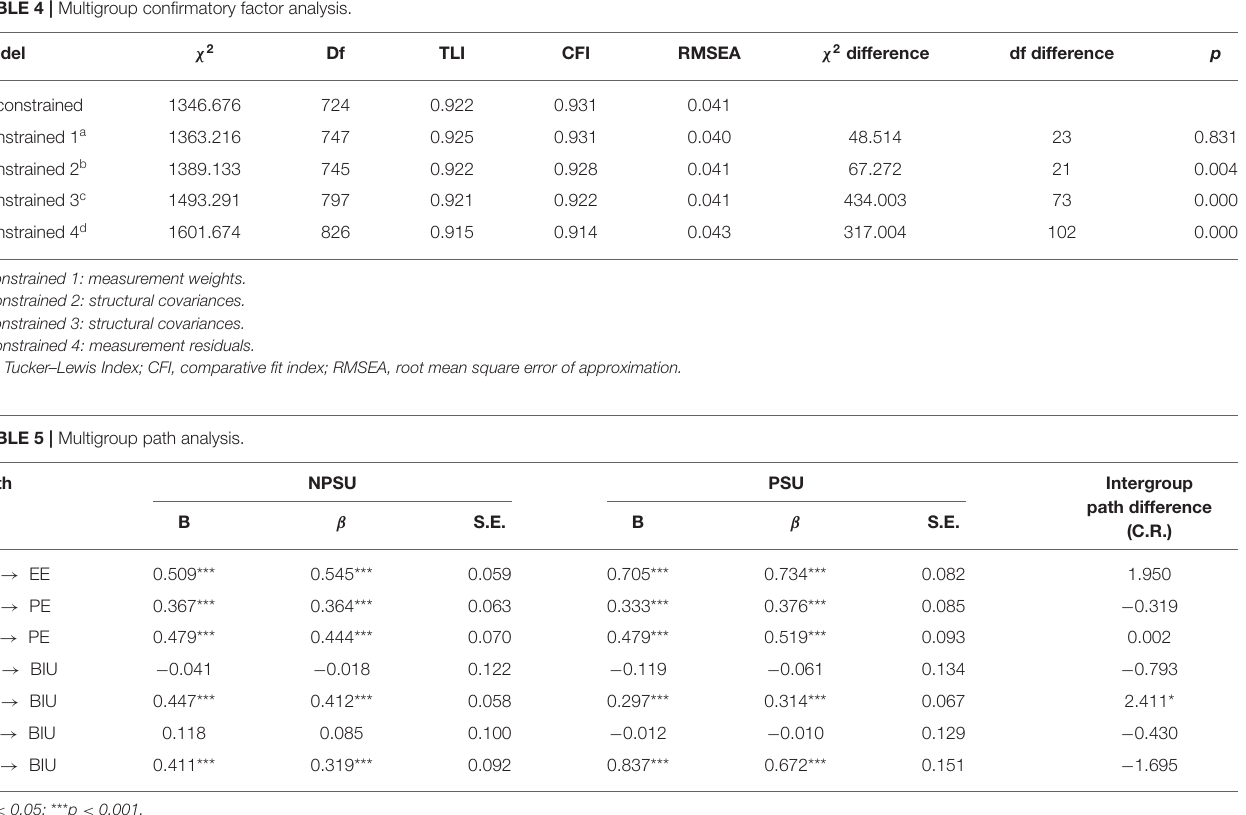
TABLE 4 | Multigroup confirmatory factor analysis.